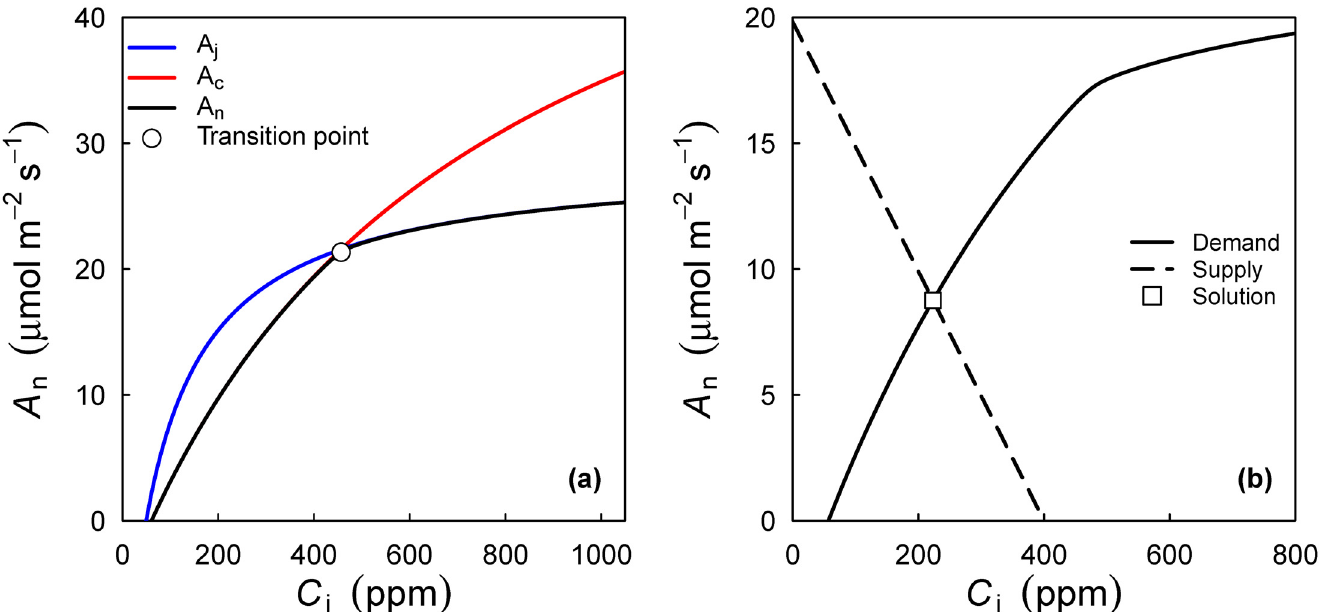
Fig 1. Supply and demand functions for leaf photosynthesis. (a) Leaf photosynthesis — CO 2 response curve as modelled with the FvCB model. (b) The intersection of the supply and demand curves of photosynthesis. The Photosyn function solves for C i if g s , V cmax , J max and R d (and other parameters to the FvCB model) are